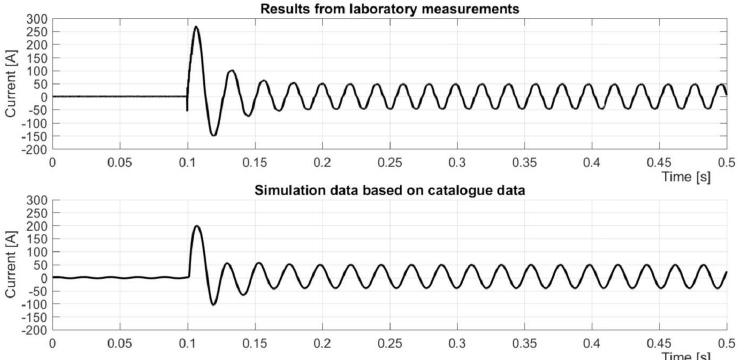
Figure 10. Short-circuit current while field forcing (case of short-circuit modeled directly on the generator clamps).